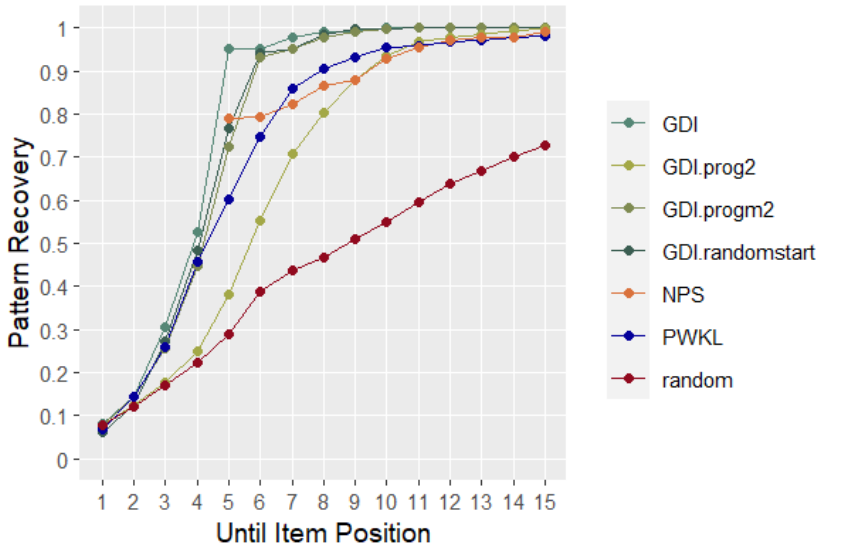
Figure 6. Pattern recovery comparison for the seven fixed-length CD-CAT implementations. GDI: general discrimination index; GDI.prog2 and GDI.progm2: progressive method for item exposure control with b = 2 and –2, respectively; GDI.randomstart: first item is selected at random; NPS: non- parametric item selection method; PWKL: posterior weighted Kullback–Leibler; random: random item selection.